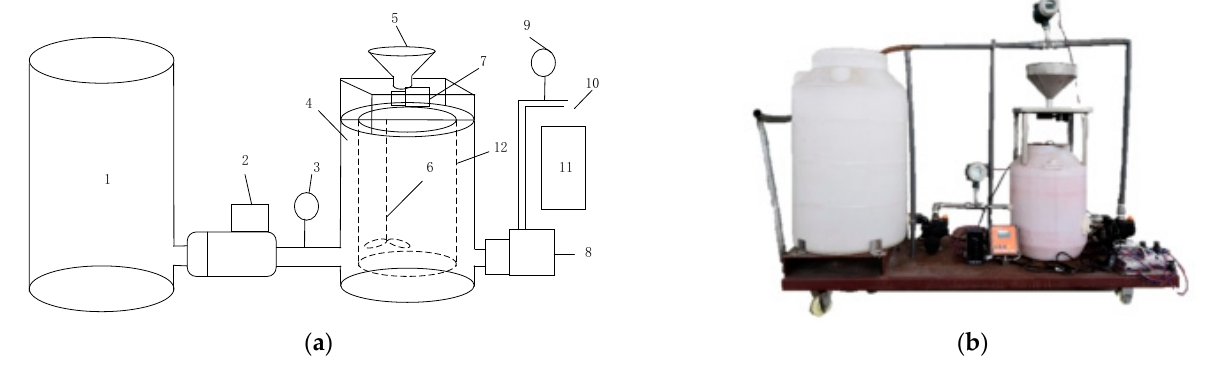
Figure 6. ( a ) Schematic diagram of the performance test of the dissolving device: (1) source of water; (2) water pump; (3) flowmeter; (4) mixed fertilizer bucket; (5) fertilizer inlet; (6) stirrer; (7) stepping motor; (8) water pump; (9) flowmeter; (10) fertilizer solution export; (11) control panel; (12) filter. ( b ) Performance test bench of the solution applicator equipped with the control system.